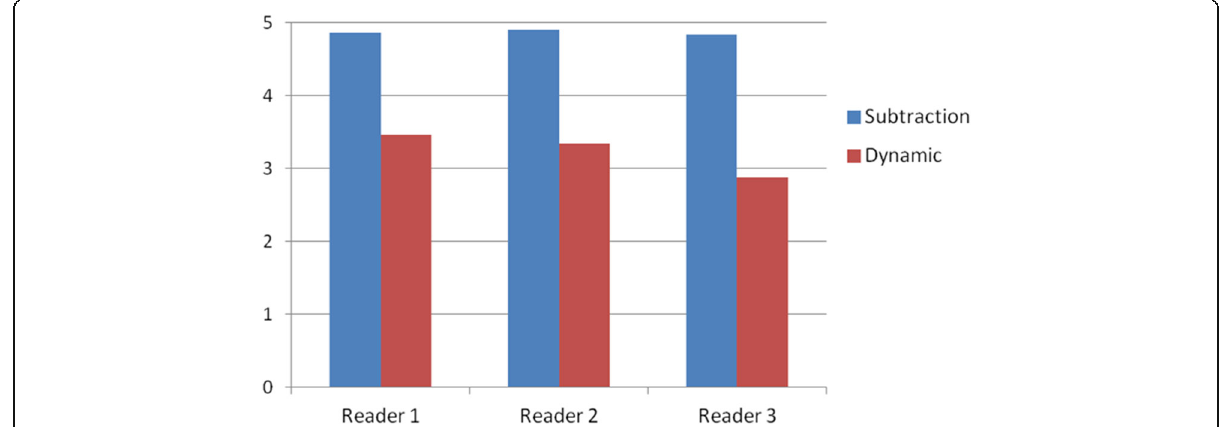
Fig. 9 Bar chart showing the confidence level for both dynamic and subtraction images among the three